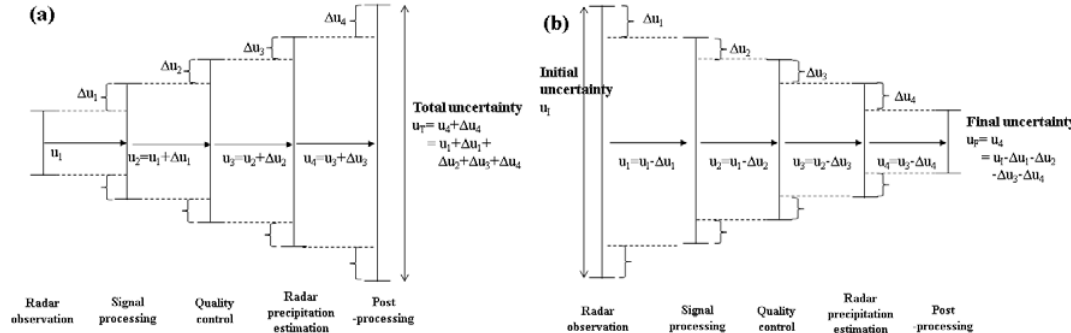
Figure 1. Definition of uncertainty quantification and propagation in the radar-based precipitation estimation process ( a ) with increasing uncertainty, ( b ) with decreasing uncertainty.